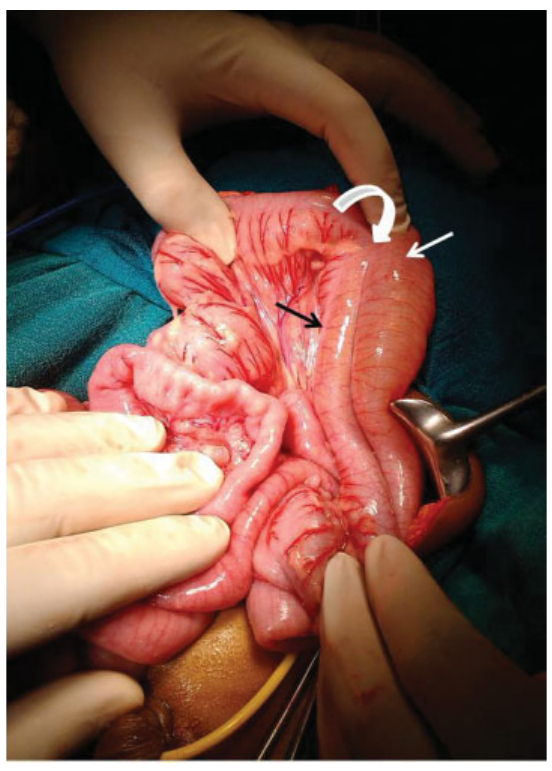
Fig. 4 Operative image showing the smaller (black arrow) and the larger (white arrow) moieties of duplicated descending colon uniting at the splenic fl exure (curved arrow). Note the separate vasculature of both moieties entering separately from the mesenteric